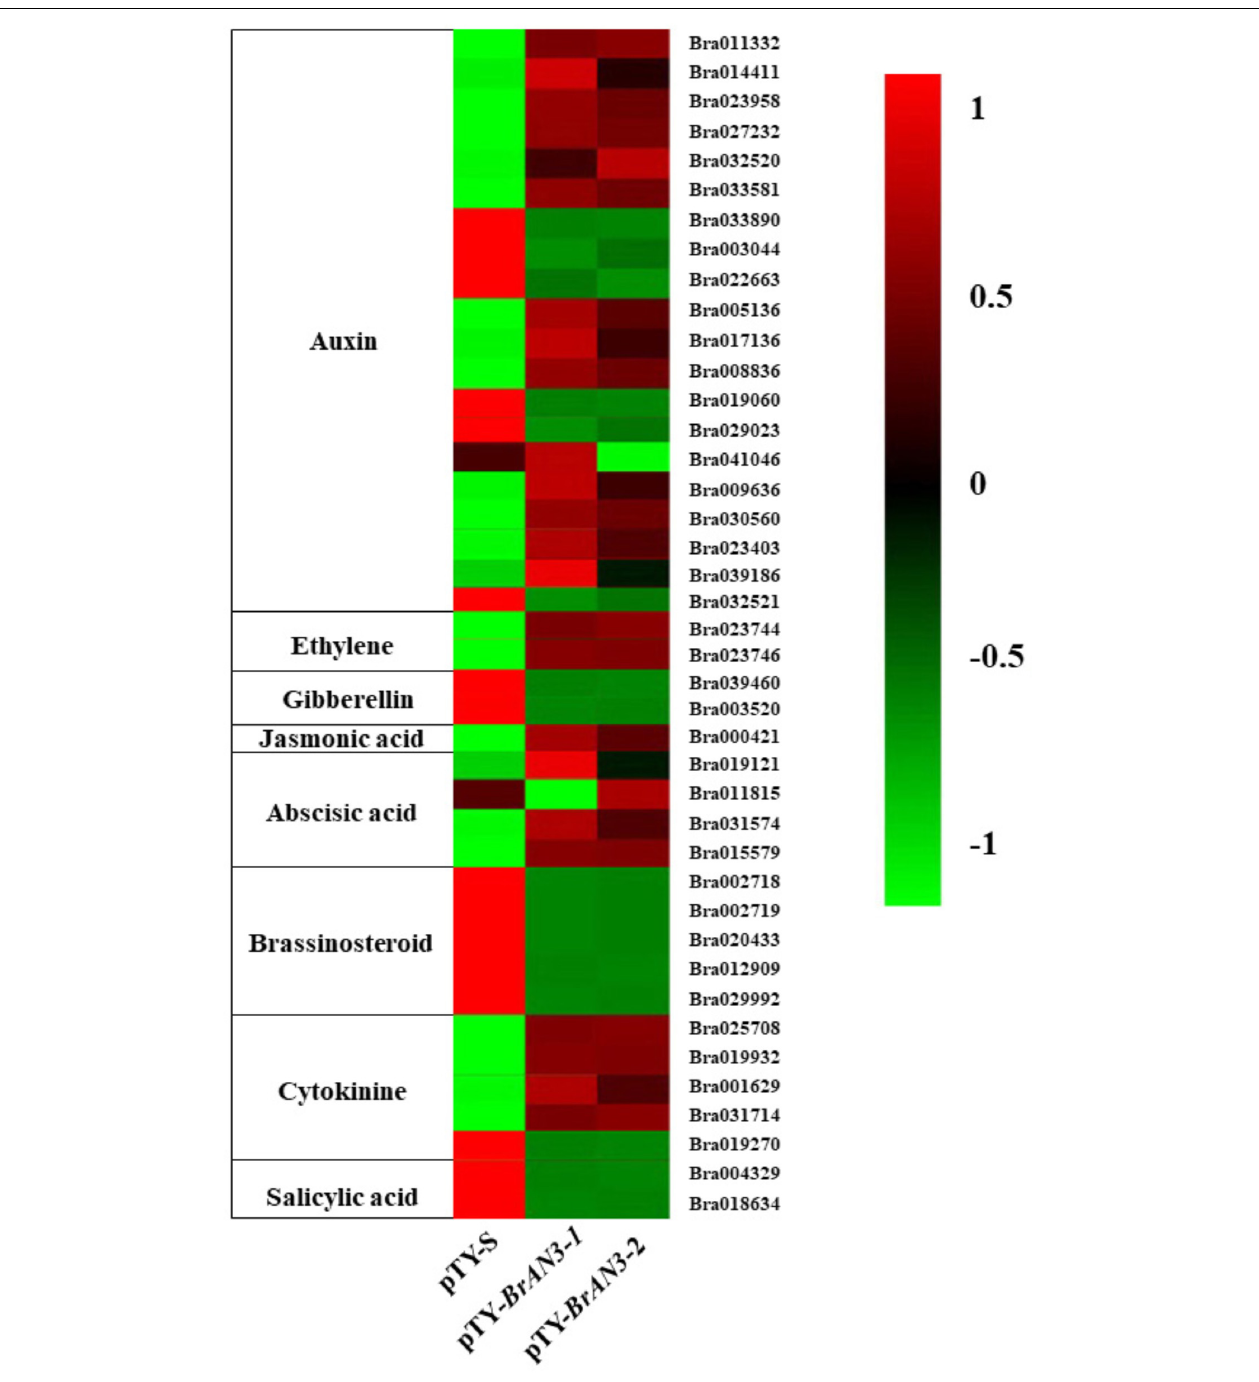
FIGURE 6 | Heatmap showing the differential expression patterns of the 41 differentially expressed genes